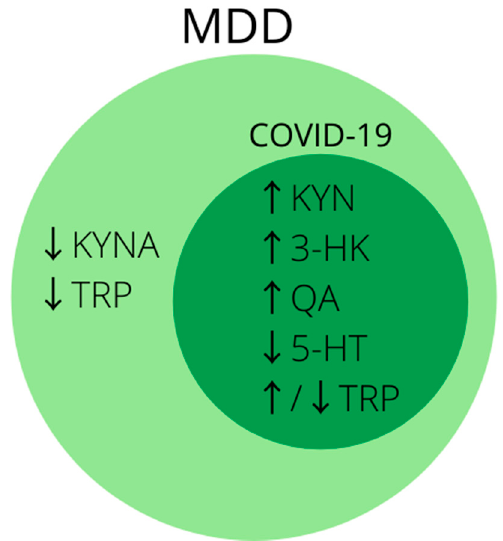
Figure 2. Summary of the most common biomarkers of activated kynurenine pathway in MDD. Note that biomarkers inside dark-green circle coincide with markers of disturbed tryptophan me- tabolism in COVID-19. Abbreviations: ↑ —increased concentration; ↓ —decreased concentration; 3-